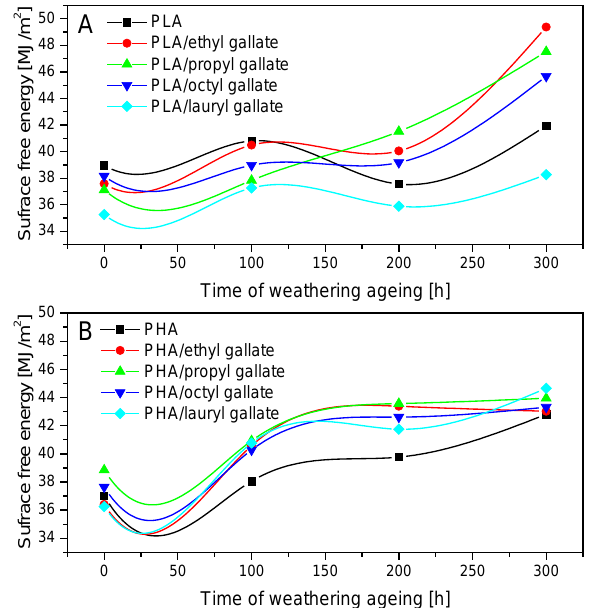
Figure 9. Changes in PLA ( A ) and PHA ( B ) surface free energy after weathering aging.